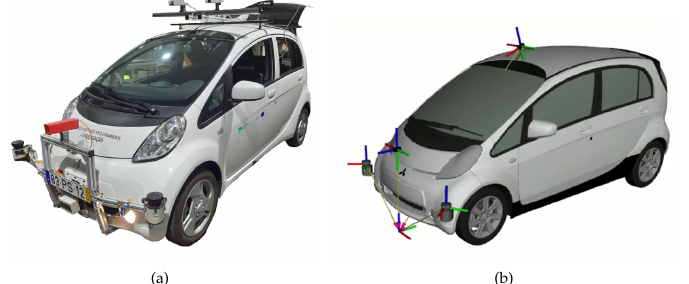
Figure 13. AtlasCar2 is an autonomous vehicle with two RGB cameras and two 2D LiDAR, besides other sensors not tackled here. ( a ) represents the real system and ( b ) represents the simulated system.